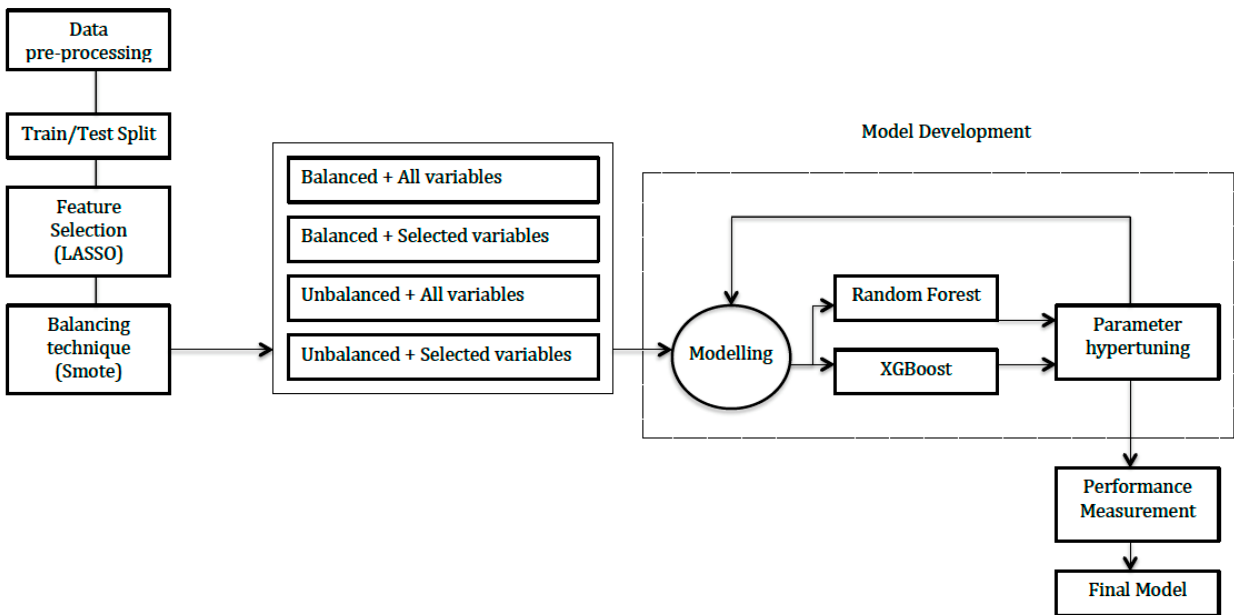
Figure 1. Full process diagram.